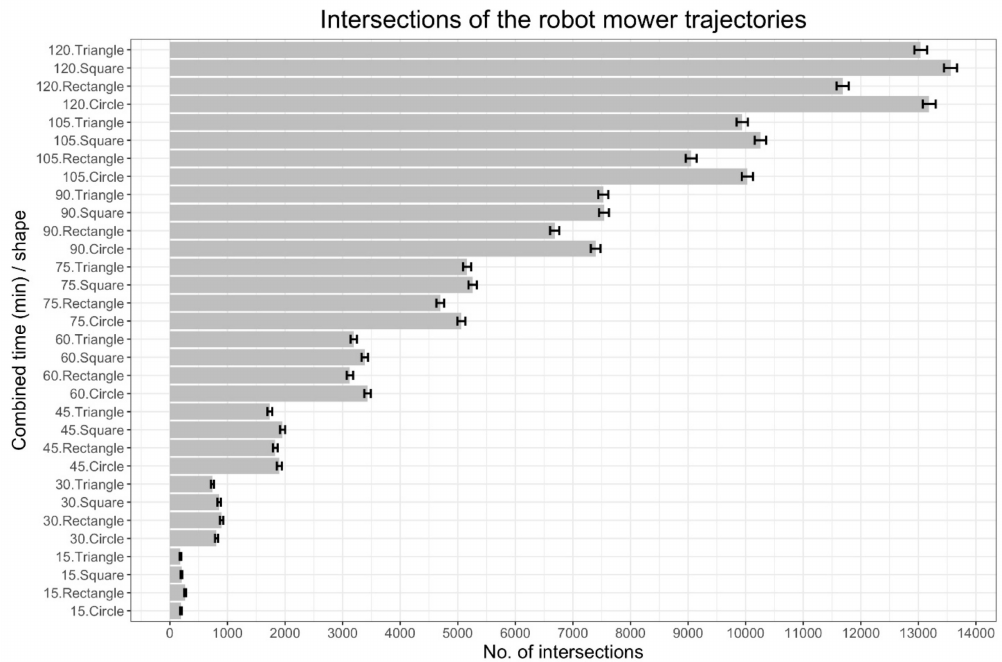
Figure 7. Inverse-transformed means and 95% confidence intervals of the number of intersections of the robot mower trajectories in the di ff erent turfgrass area shapes (square, rectangle, triangle, and circle) at 15, 30, 45, 60, 75, 90, 105, and 120 min from the start of the